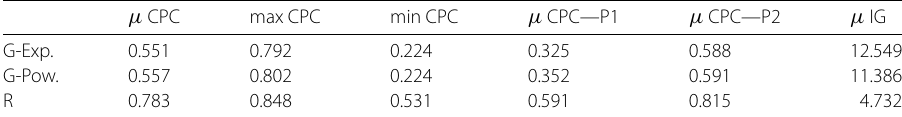
Table 3 CPC of the three models when dealing with outgoing mobility. Differently from the incoming mobility, the outgoing mobility before the introduction of non-pharmaceutical interventions can be modeled with all the three approaches with similar performances. However, in the second period, the performances of the radiation model raise up to a CPC of 0.815 while both the gravity models’ performances decrease to 0.183 and 0.254. Concerning IG, the best performances are reached by R (4.732) followed by G-Pow (11.386) and G-Exp (12.549) μ CPC max CPC min CPC μ CPC—P1 μ CPC—P2 μ IG G-Exp.